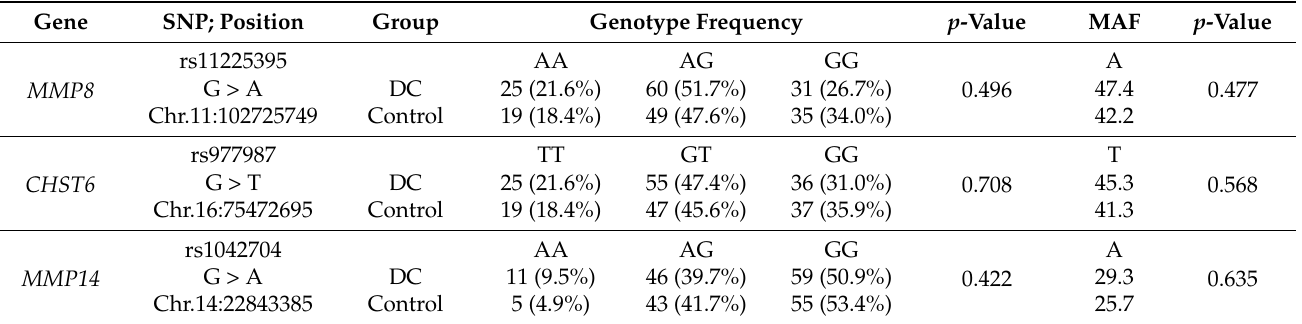
Table 2. Distribution of genotypes and allele frequencies for polymorphisms at MMP8 , CHST6 , and